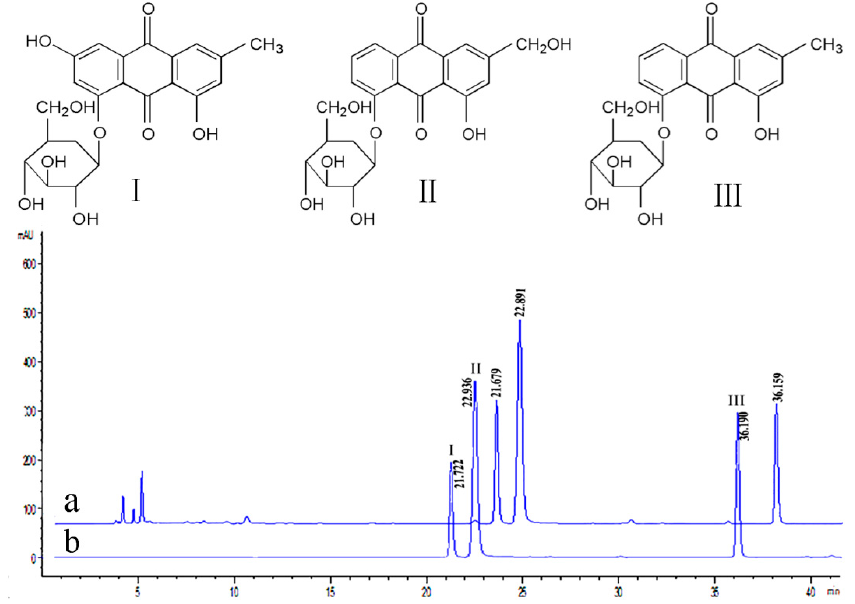
Figure 1. The structure of the emodin-8- O - β - d -glucoside ( I ), aloe-emodin-8- O - β - d -glucoside ( II ), and chrysophanol-8- O - β - d -glucoside ( III ) and HPLC chromatogram of purified anthraquinone- Glycoside from Rheum palmatum L. (PAGR) ( a ) and mixed Reference ( b